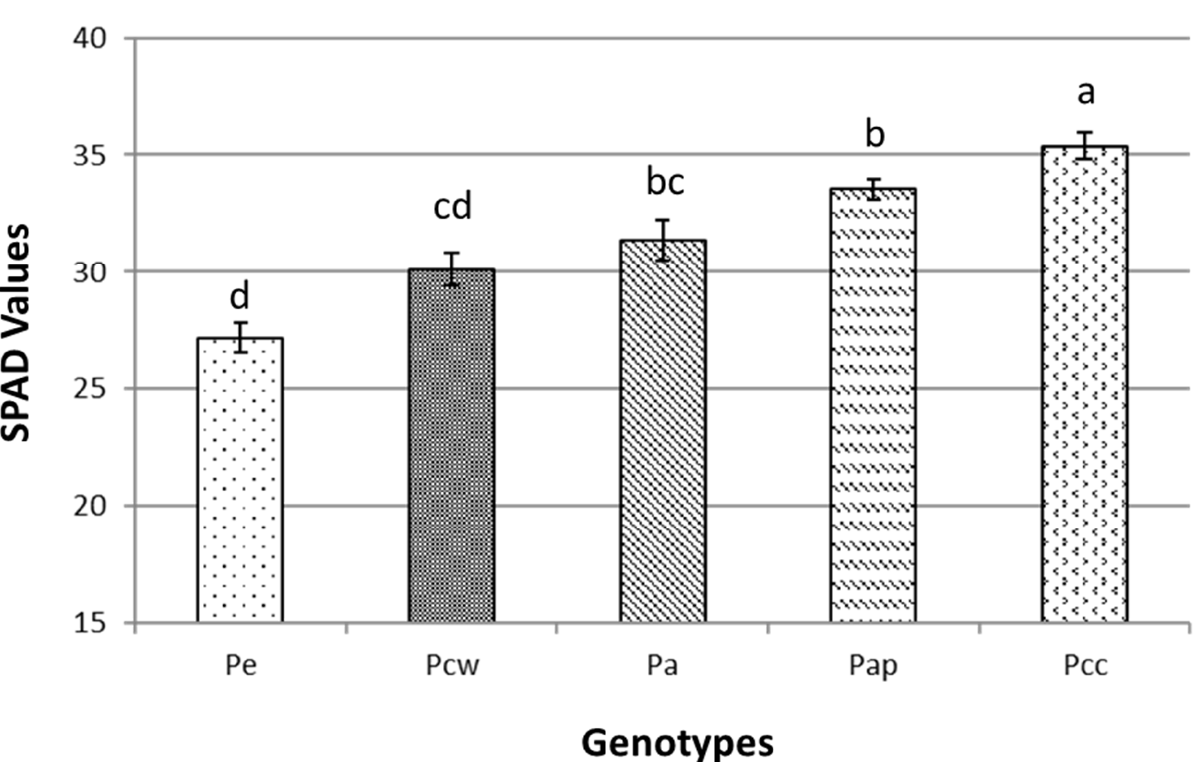
Figure 3. Average total chlorophyll level (SPAD) measured in leaves from four interspecific Pyrus hybrids (Pa, Pap, Pcc, Pe) and open pollinated Pyrus communis ‘Williams’ (Pcw) under in vitro iron deficiency conditions. Since no significant interaction was observed between NaHCO 3 and Pyrus species ( p = 0.452), mean values come from the measures of 32 replicates per genotype. Bars represent the standard error. Hybrids with different letter are significantly different (Tukey, p < 0.05).